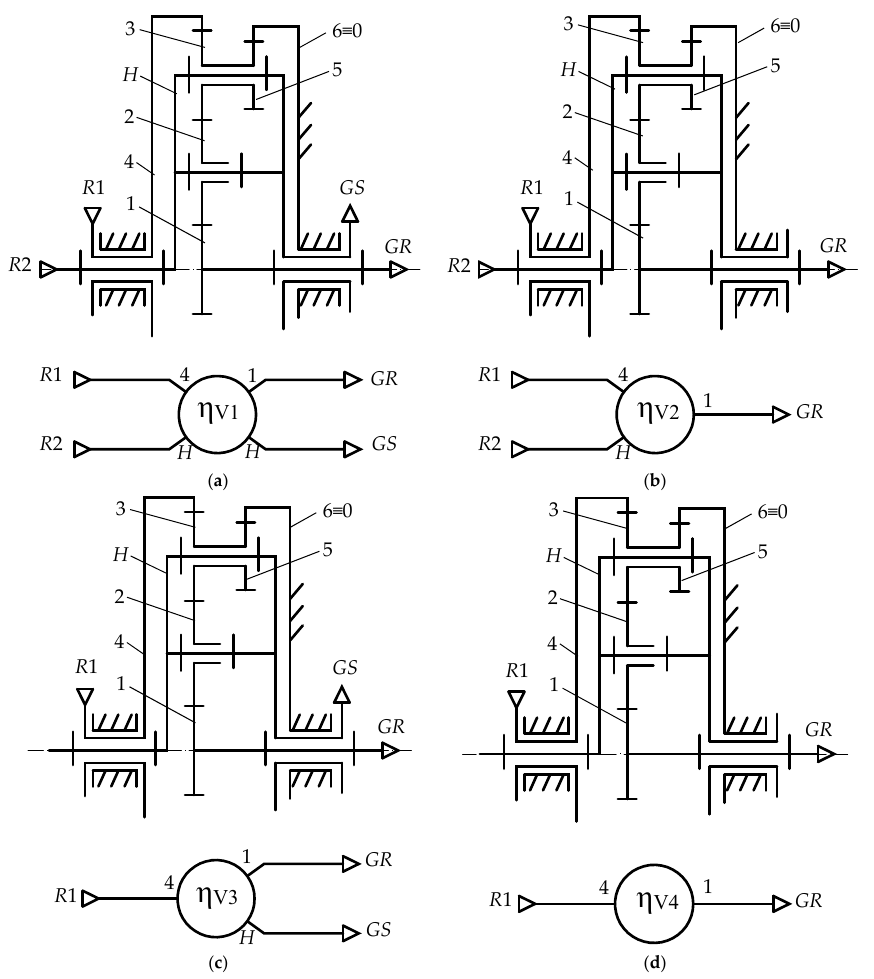
Figure 5. Structural and block diagrams of the 1-DOF speed increaser in Figure 4a with ( a ) two inputs and two outputs (variant V1 ); ( b ) two inputs and one output (variant V2 ); ( c ) one input and two outputs (variant V3 ) and ( d ) one input and one output (variant V4 ).